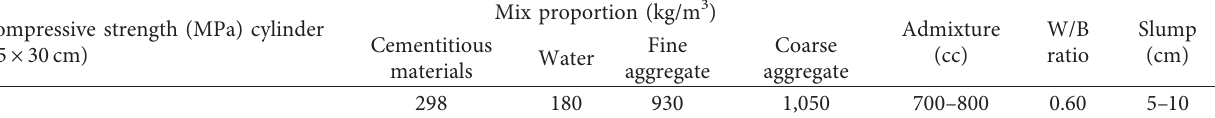
Table 6: Mix proportion for the compressive strength of concrete, 28MPa at an age of 28 days. Compressive strength (MPa) cylinder